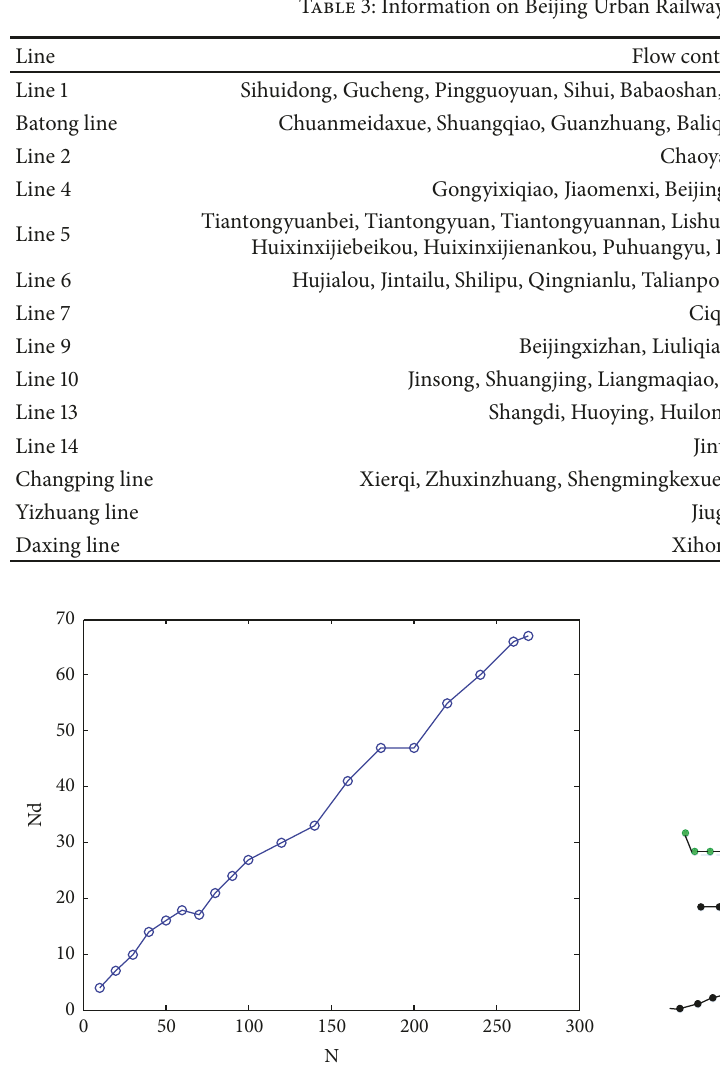
Table 3: Information on Beijing Urban Railway passenger control stations.